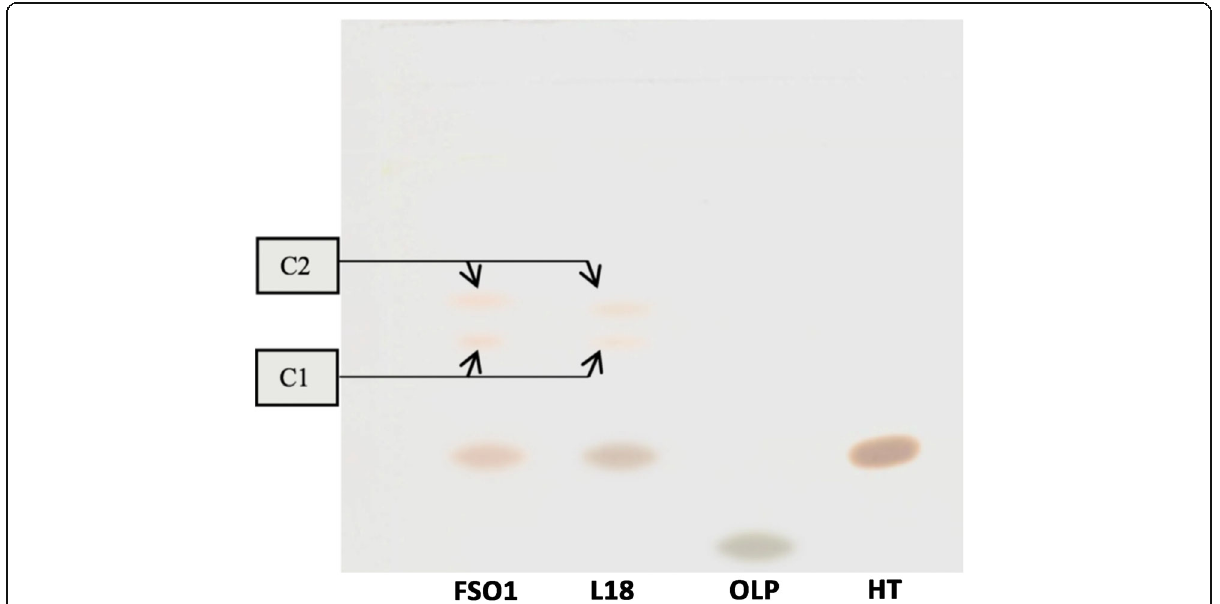
Fig. 4 TLC of the methanolic fraction of oleuropeinolytic strains extracts and standards developed by toluene/methanol/acetic acid system (15/5/ 0.5) and observed under white light. (Legend: FSO1: L. plantarum FSO1, L18: C. pelliculosa L18, OLP: oleuropein, HT: